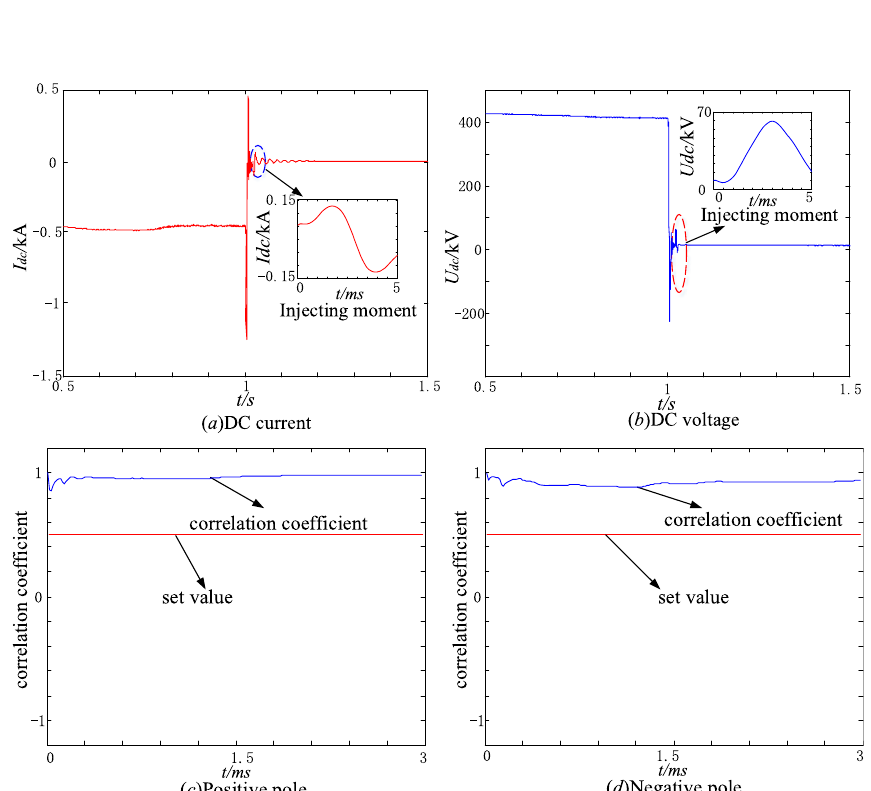
Fig. 13 f 2 point fault